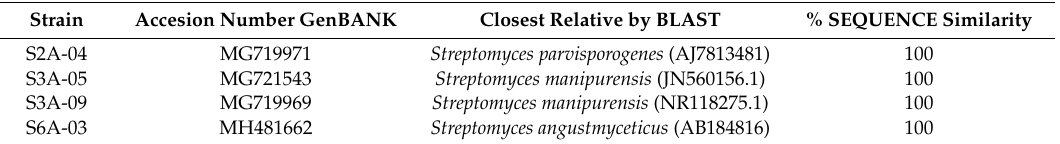
Table 1. 16S ribosomal RNA gene taxonomic a ffi liation of Streptomyces strains isolated from tropical acidic soils in the state of Tabasco,